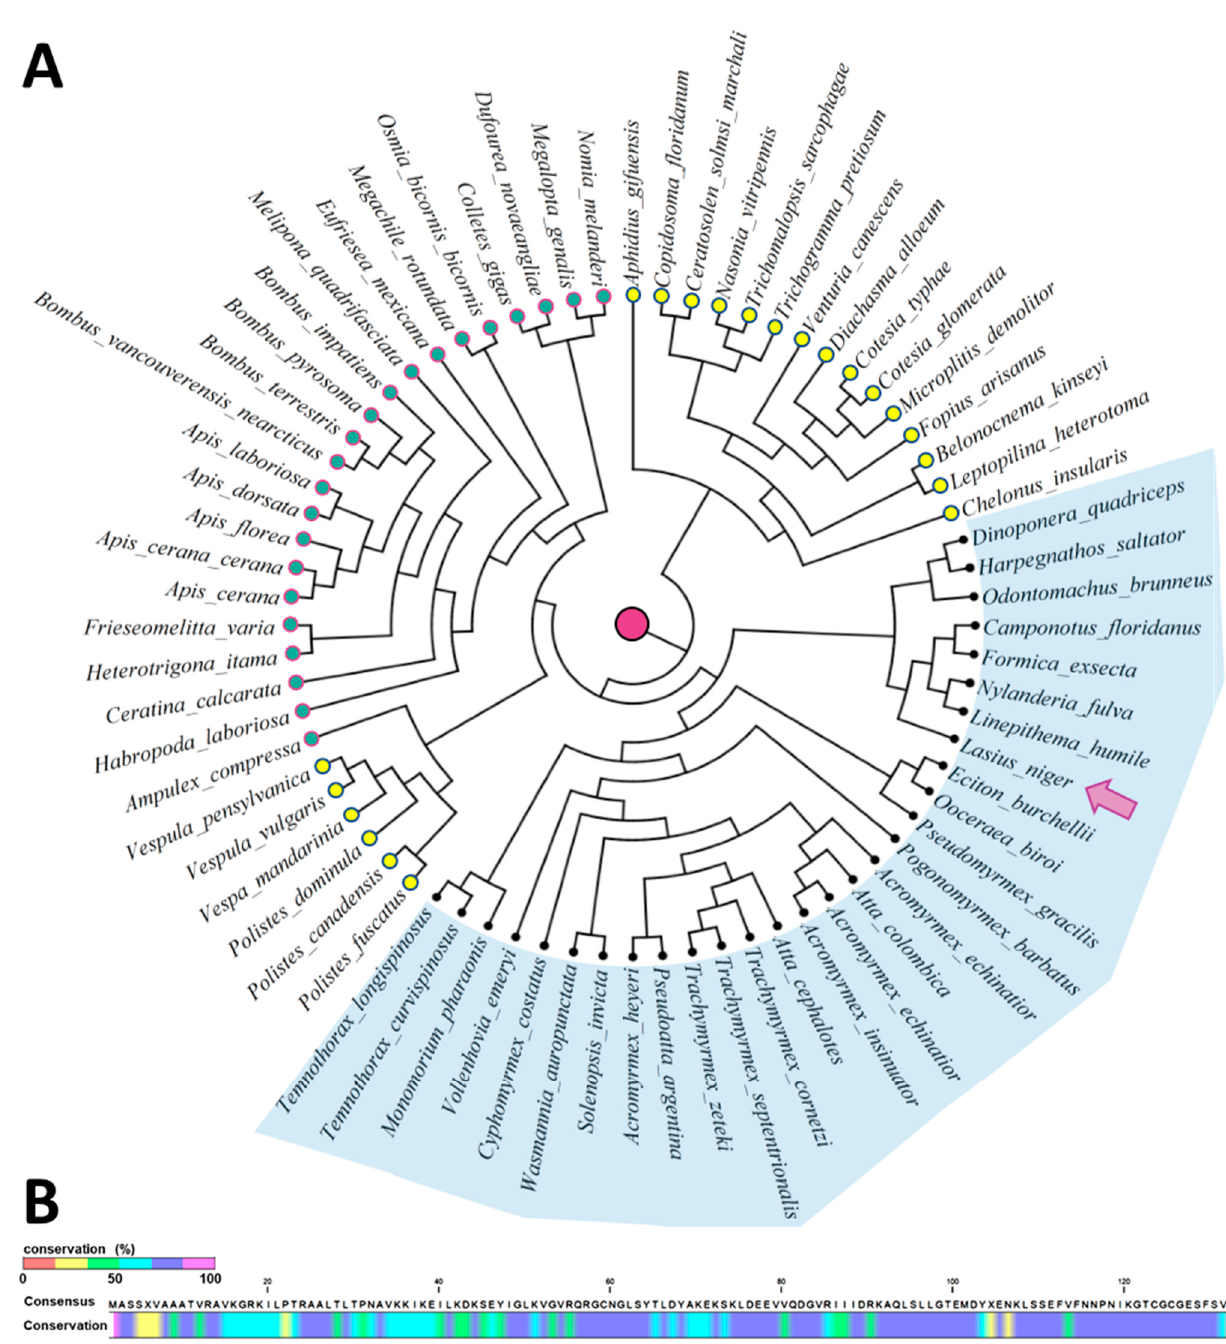
Figure 6. Phylogenetic analysis of the amino-acid sequence of MagR protein. ( A ) Phylogenetic tree of MagR originated from differences in amino-acid composition between Drosophila melanogaster (magenta dot in the center) and proteins identified in ants (blue shadow), bees (green dots), and wasps (yellow dots). The circular tree shows that the protein amino-acid sequences of phylogenetically close organisms are highly conserved, as suggested by their linking distance. The circular tree was originated by downloading the amino-acid sequences from NCBI, while the distance of each entry was calculated using BLAST tool as described in Section 3. ( B ) Sequence alignment of MagR in ants, wasps, and bees. Highly conserved residues among the analyzed species are shown in dark blue (>75% and <90%) or pink (>90%), while lowly conserved motif residues are colored in red, yellow, or green according to the conservation percentage (see percentage bar color legend).